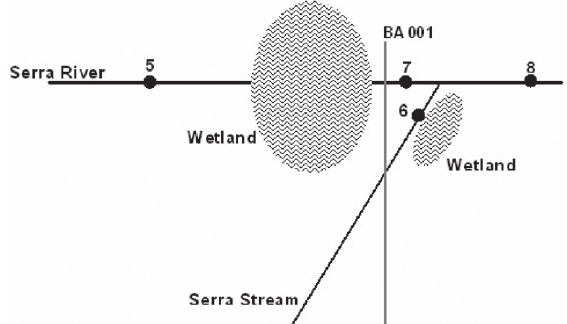
Figure 8 - Schematic drawing of a patch of the Rio da Serra Basin, with emphasis on the location of the wetlands at point 6 and between points 5 and